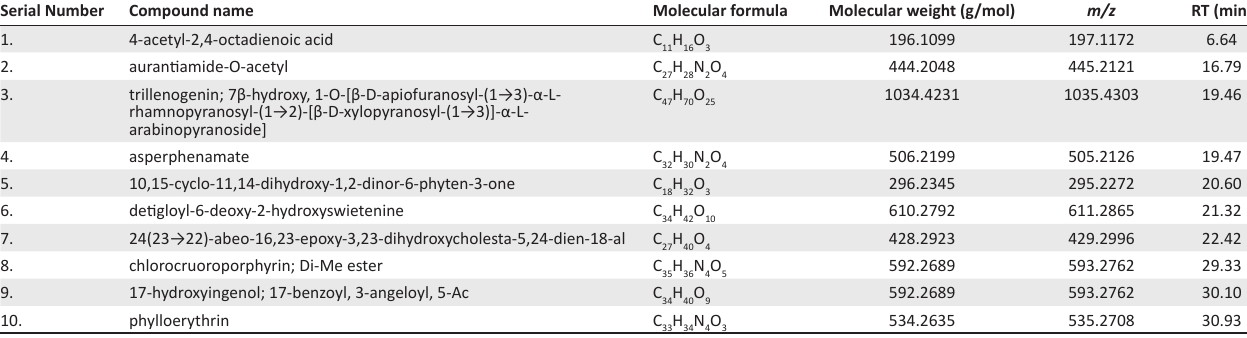
FIGURE 6: Original representative recording showing the effect of D. filix-mas (DF) on oxytocin-induced uterine contraction in calcium-deprived medium. DF appeared to have little effect on oxytocin when a calcium-free medium was used, although slight depressions were observed at the highest concentrations of DF used in this study. n = 5 animals. TABLE 1: Putatively identified compounds in Dryopteris filix-mas .